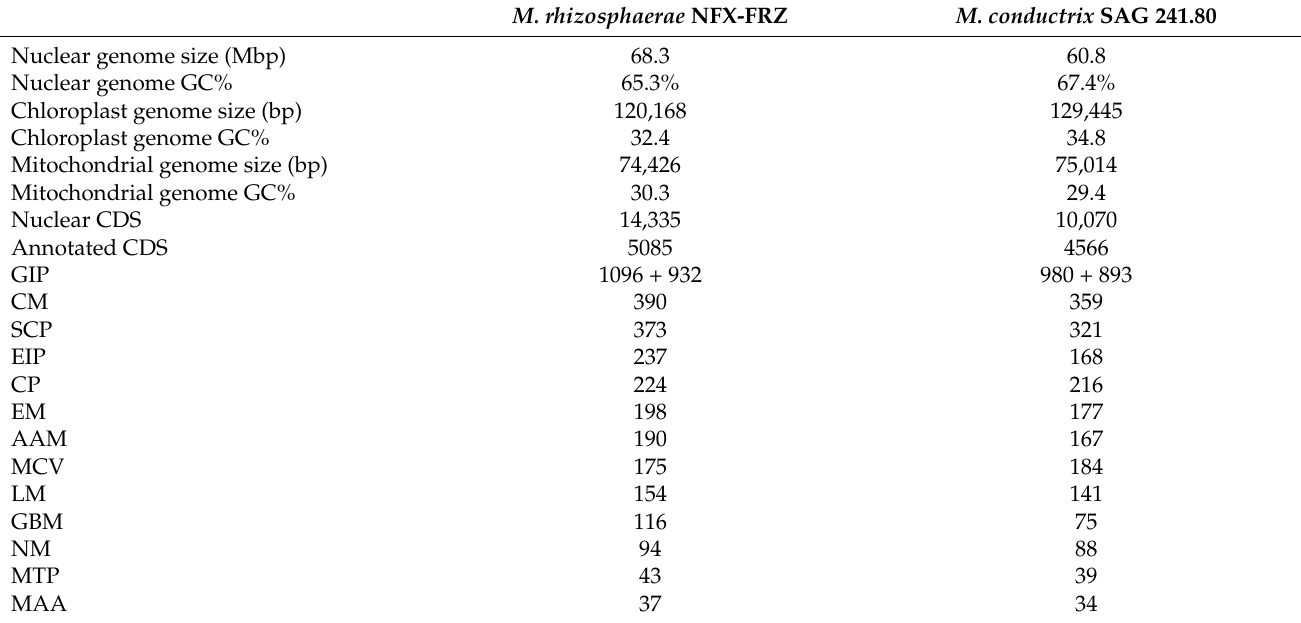
Table 3. Genomic properties of M. rhizosphaerae NFX-FRZ and M. conductrix SAG